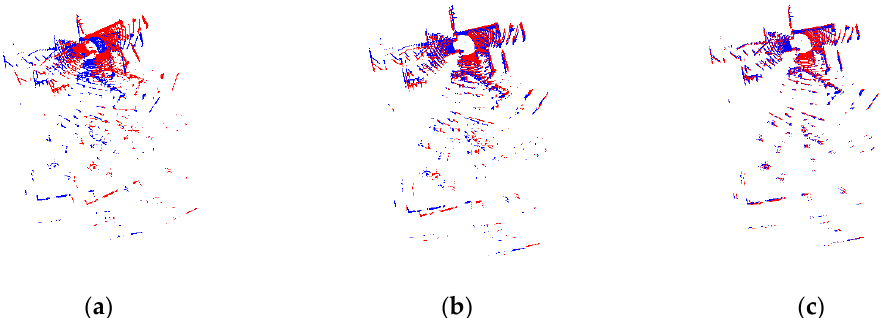
Figure 7. Point cloud registration results. ( a ) Original source and target point clouds. ( b ) Alignment results using ICP algorithm. ( c ) Alignment results using our algorithm.